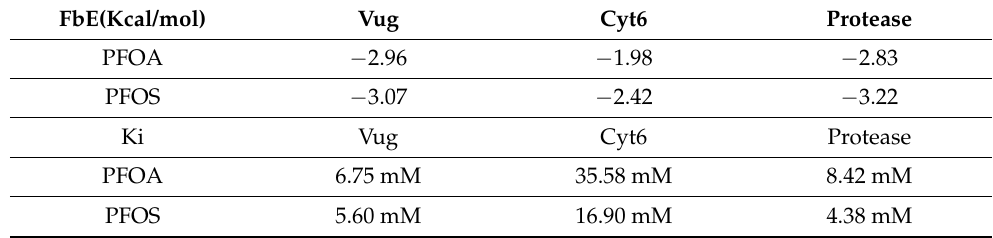
Table 3. Free binding energy and Ki of interaction between photosystem ii d1 c-terminal processing protease, oxidized cytochrome c6 proteins, and carboxypeptidase t with n-sulfamoyl-l-lysin in vulgaris and ligands. FbE(Kcal/mol) Vug